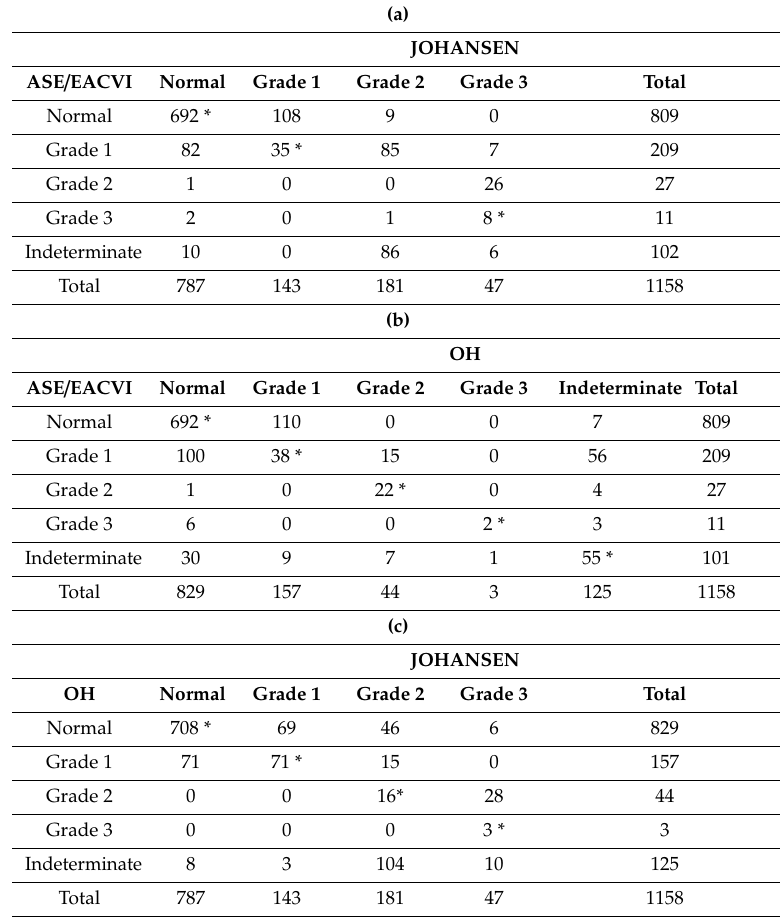
TableA2. Thenumberdiastolicgradesconferredusing( a )ASE / EACVIandJOHANSEN,( b )ASE / EACVI and OH, and ( c ) OH and